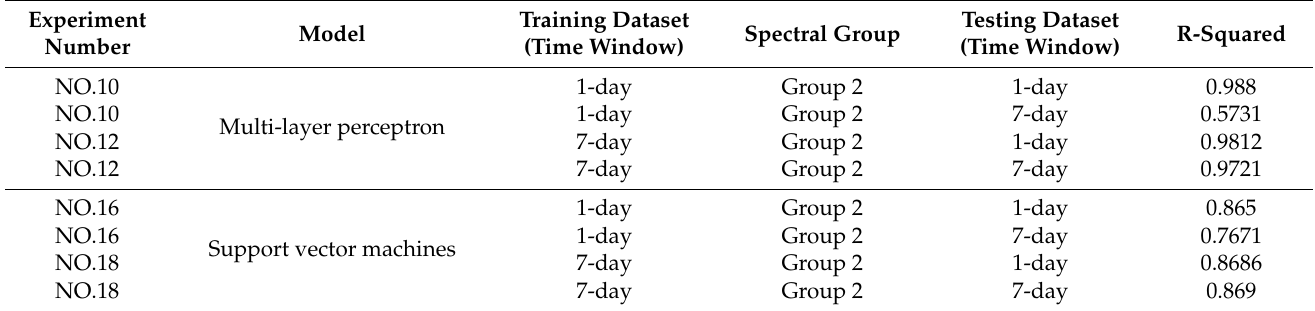
Table 6. Influence of the time window of the training set on the prediction results of the machine- learning model (in the case of spectral variable group 2). Group 2 represents the spectral variables that use a band combination and band ratio combination. The experiment number corresponds to Table